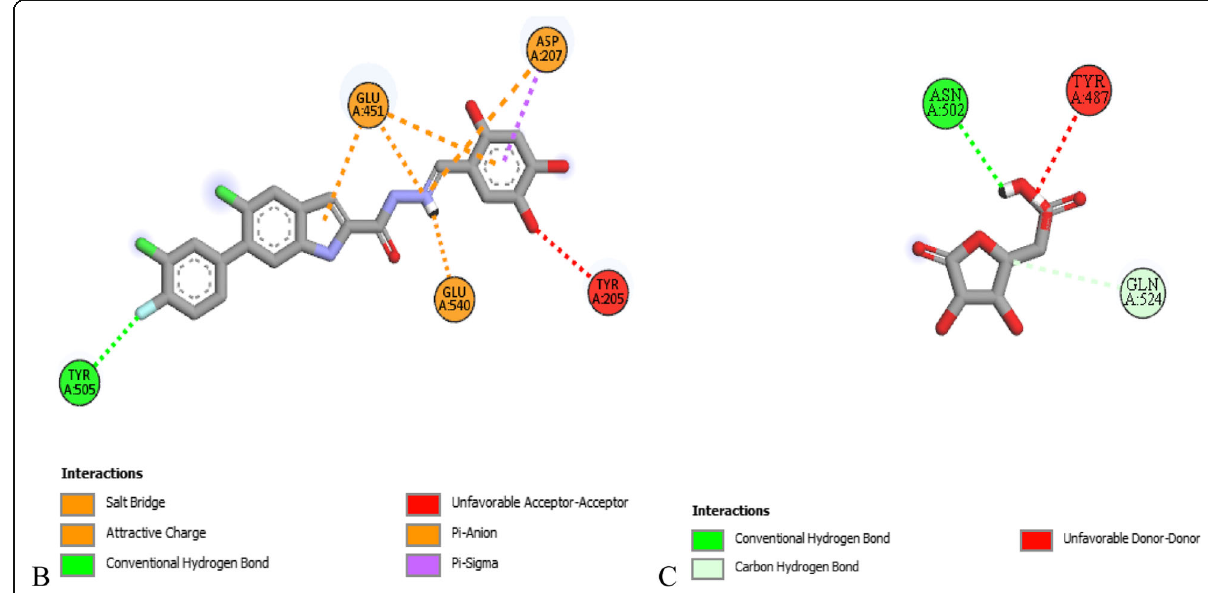
Fig. 6 The 2D structure of visualized a ID 4-Receptor, b standard